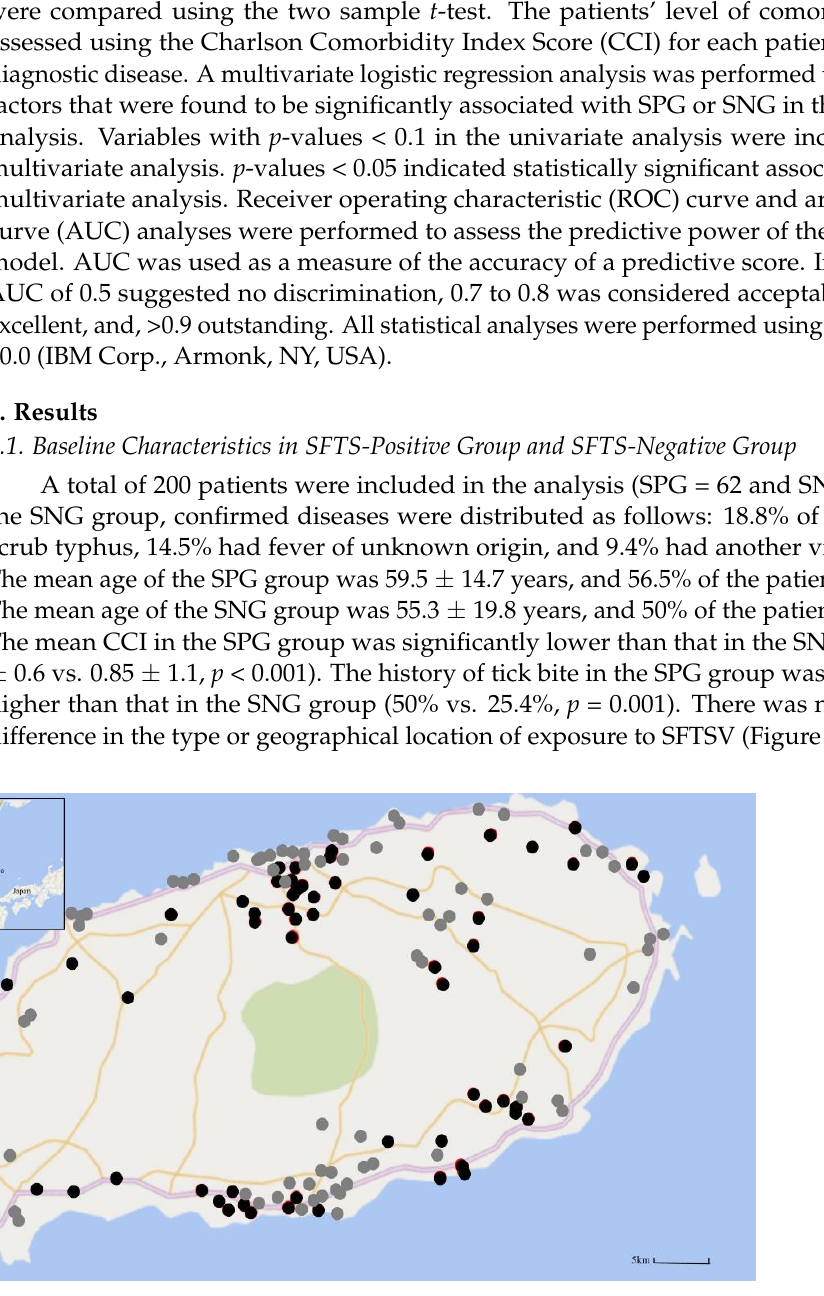
Figure 1. Geographic distribution of patients of the severe fever with thrombocytopenia syndrome (SFTS) and non-SFTS groups on Jeju Island (2013–2019). Black closed circles indicate the site of SFTS virus (SFTSV) infection, and gray closed circles indicate the site of non-SFTS disease.